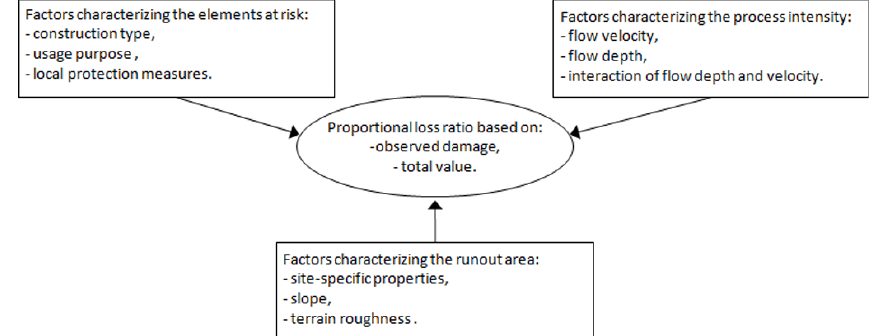
Fig. 1. Conceptual framework for the empirical analysis of proportional loss data.